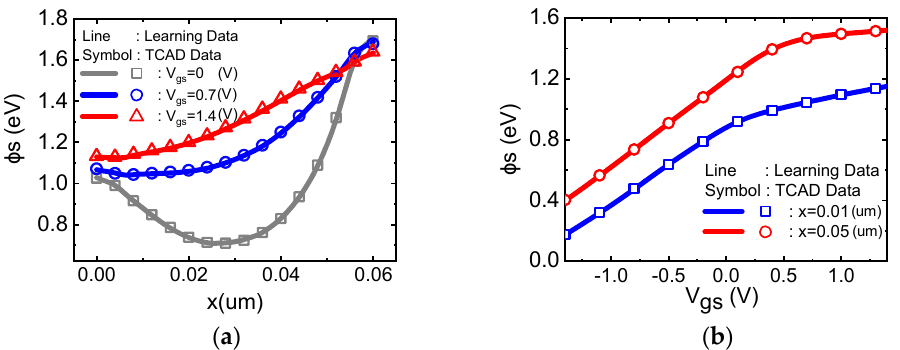
Figure 4. An excellent match between our PRNN model (lines) and the TCAD numerical simulation (symbols) for ( a ) the surface potential φ s along the device channel against different gate voltages and ( b ) the surface potential against the gate voltage at the source/drain terminal.